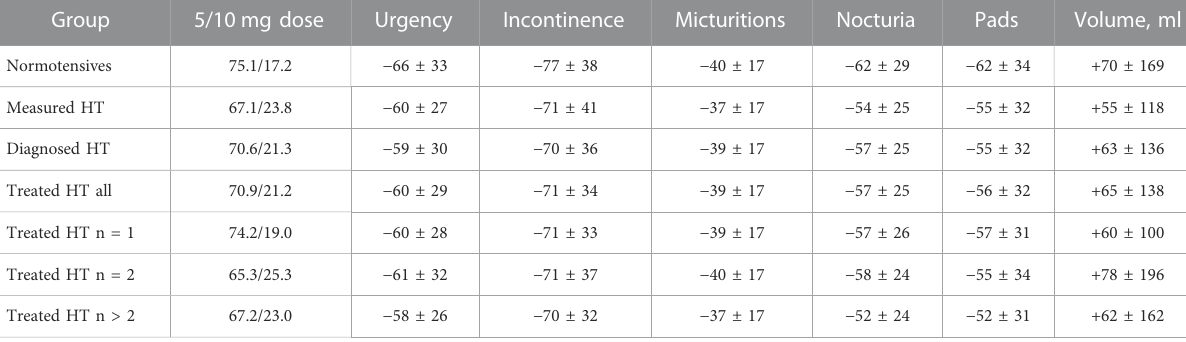
TABLE 3 Treatment responses in normotensive and hypertensive